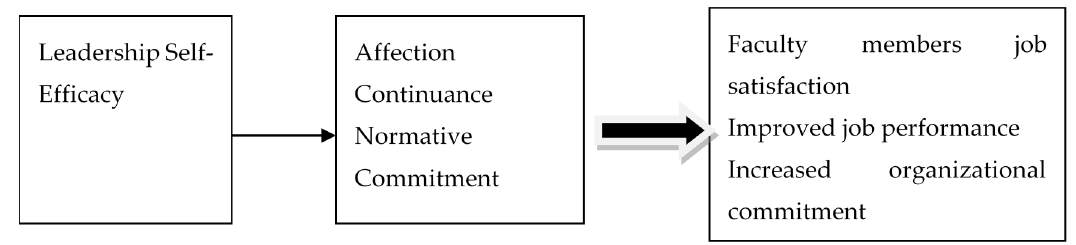
Figure 1. Conceptual framework of the study.